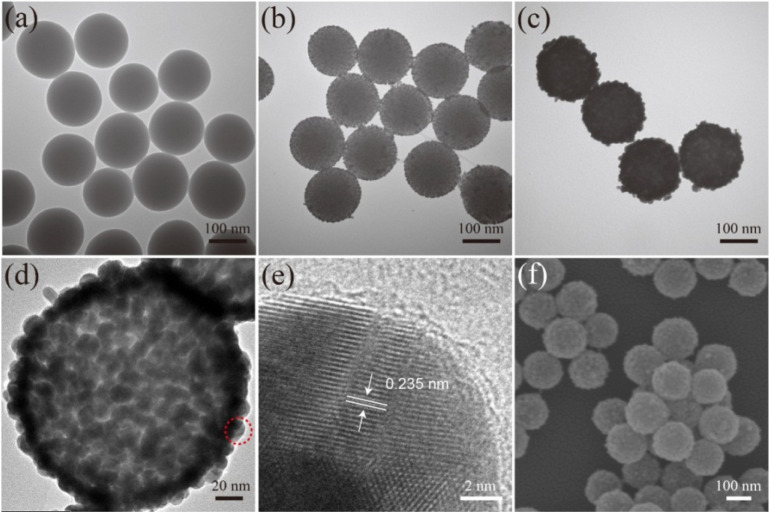
Characterization of synthesis SiO2/Au NPs. TEM images of SiO2
(a), SiO2/PEI-seed (b), and SiO2/Au (c). HRTEM images (d,e) and SEM image (f) of SiO2/Au NPs.